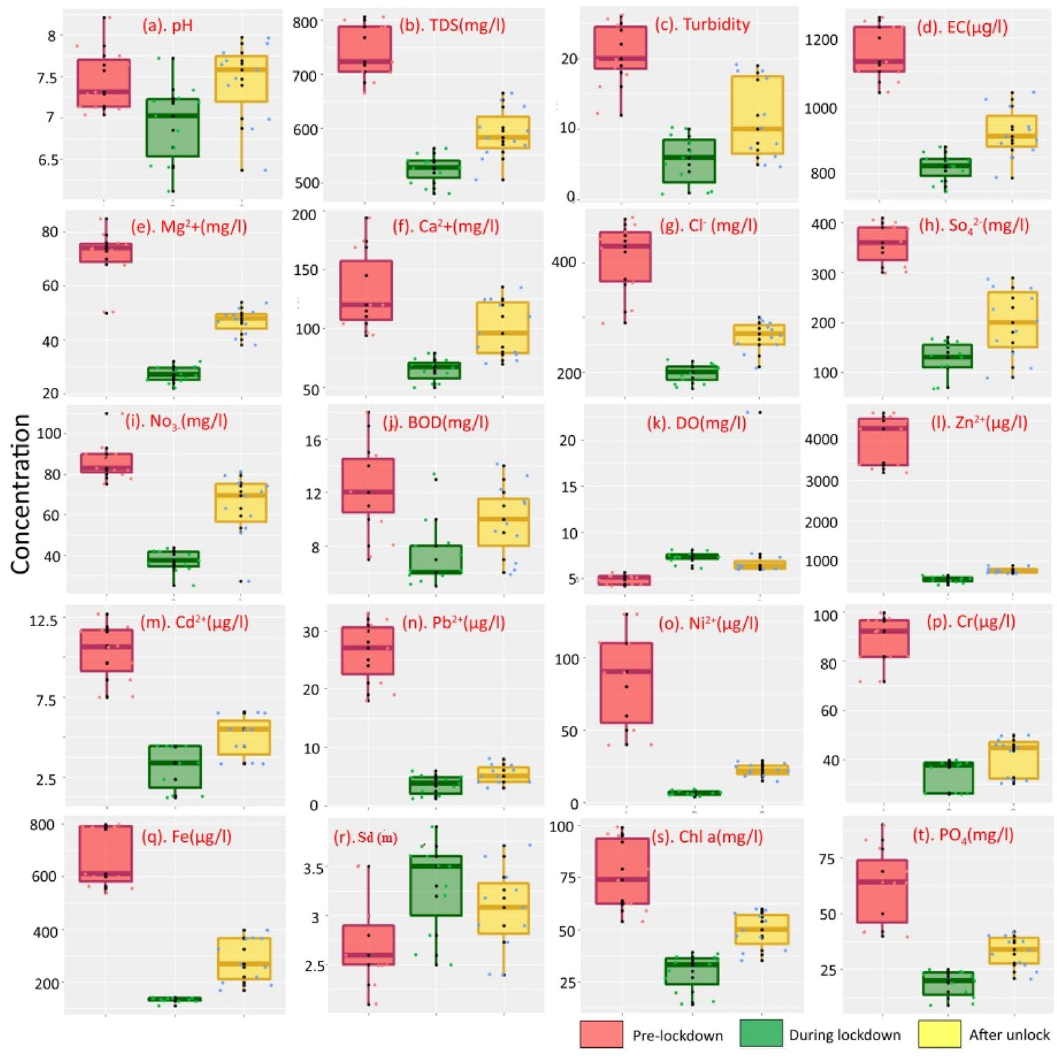
Figure 2. Box and whisker plot of different cations, anions and heavy metals concentration in three periods. This diagram is prepared by open. source R 4.1.1 software (https:// cran.r- proje ct. org/ bin/ windo ws/